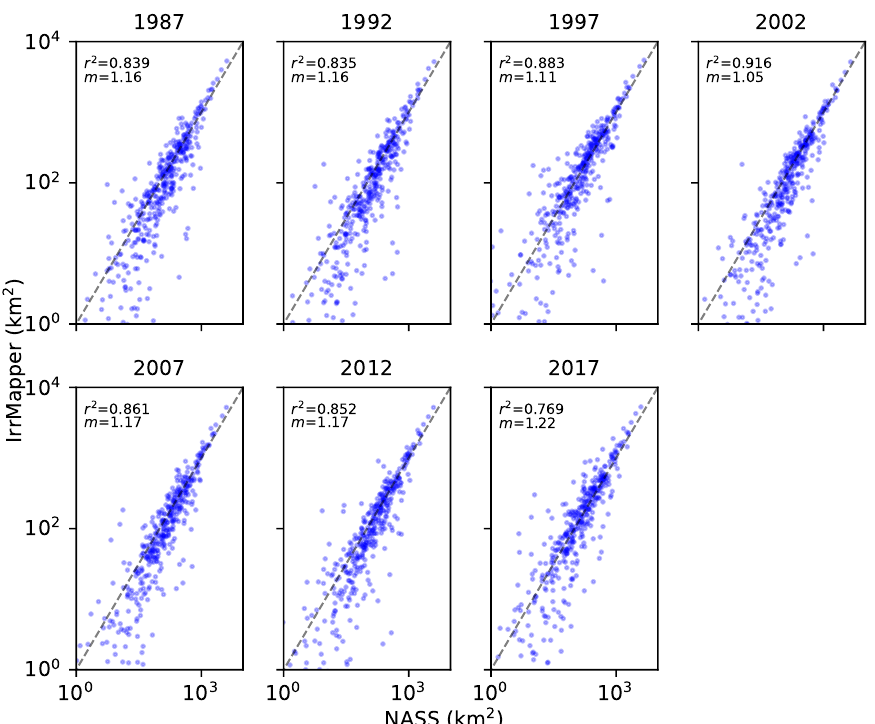
Figure 8. Comparison of NASS Census of Agriculture and IrrMapper estimates of county-level irrigated area. Comparison is over the 412 counties within the study region.